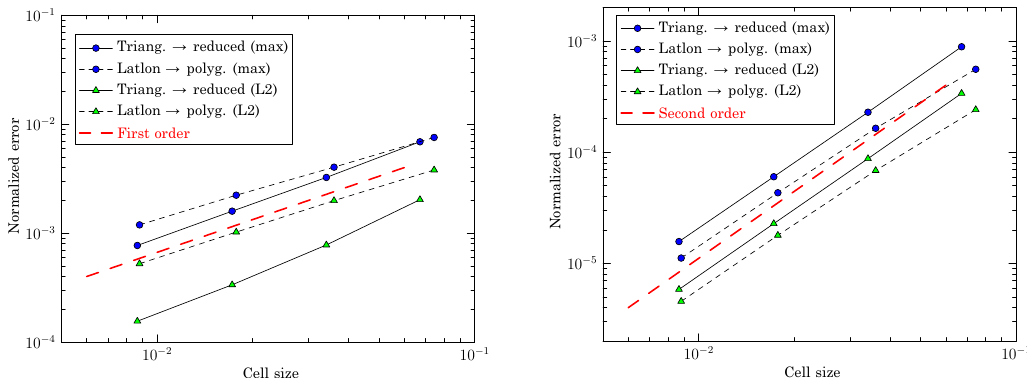
Figure 5. L 2 and L ∞ errors vs. characteristic mesh length h for the remapping of Y 2 piece-wise linear reconstruction.